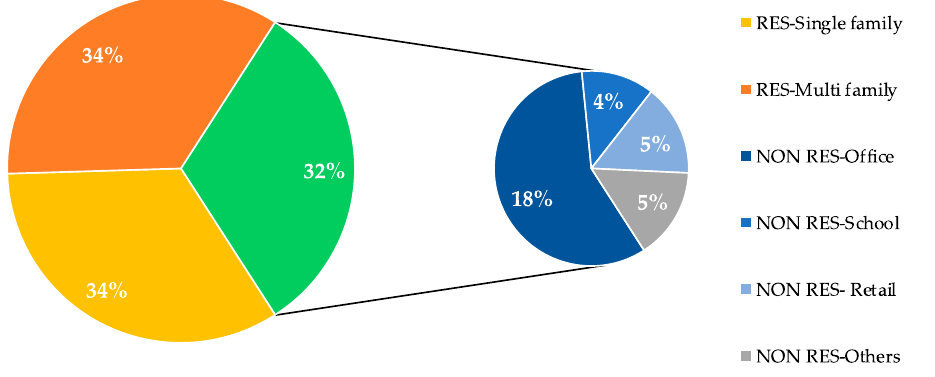
Figure 8. Reference buildings analyzed by building typology.